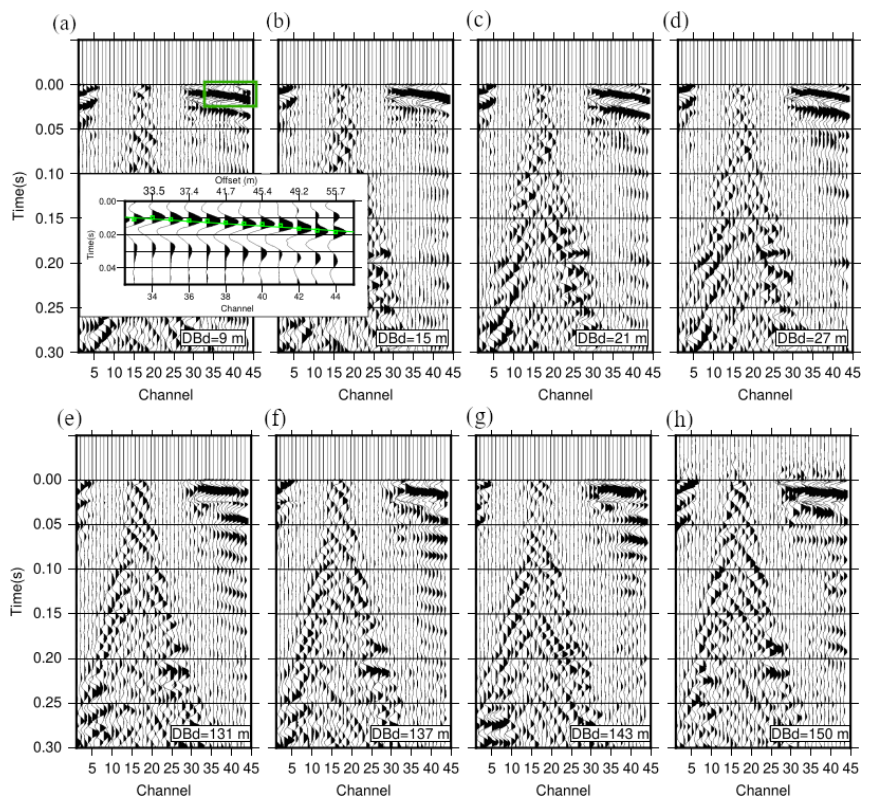
Figure 5. Shot-gathers of the processed real data generated with the drill-bit source at different depths (marked as DBd): 9 to 27m (a–d) , and 131 to 150m depth (e–h) . A time-window of 50ms before zero-time is also displayed for better visualisation of the first arrivals. The inset panel in (a) shows the enlarged version of the traveltimes encompassed by the green rectangle, the first-breaks picks and their best-fit linear trend.